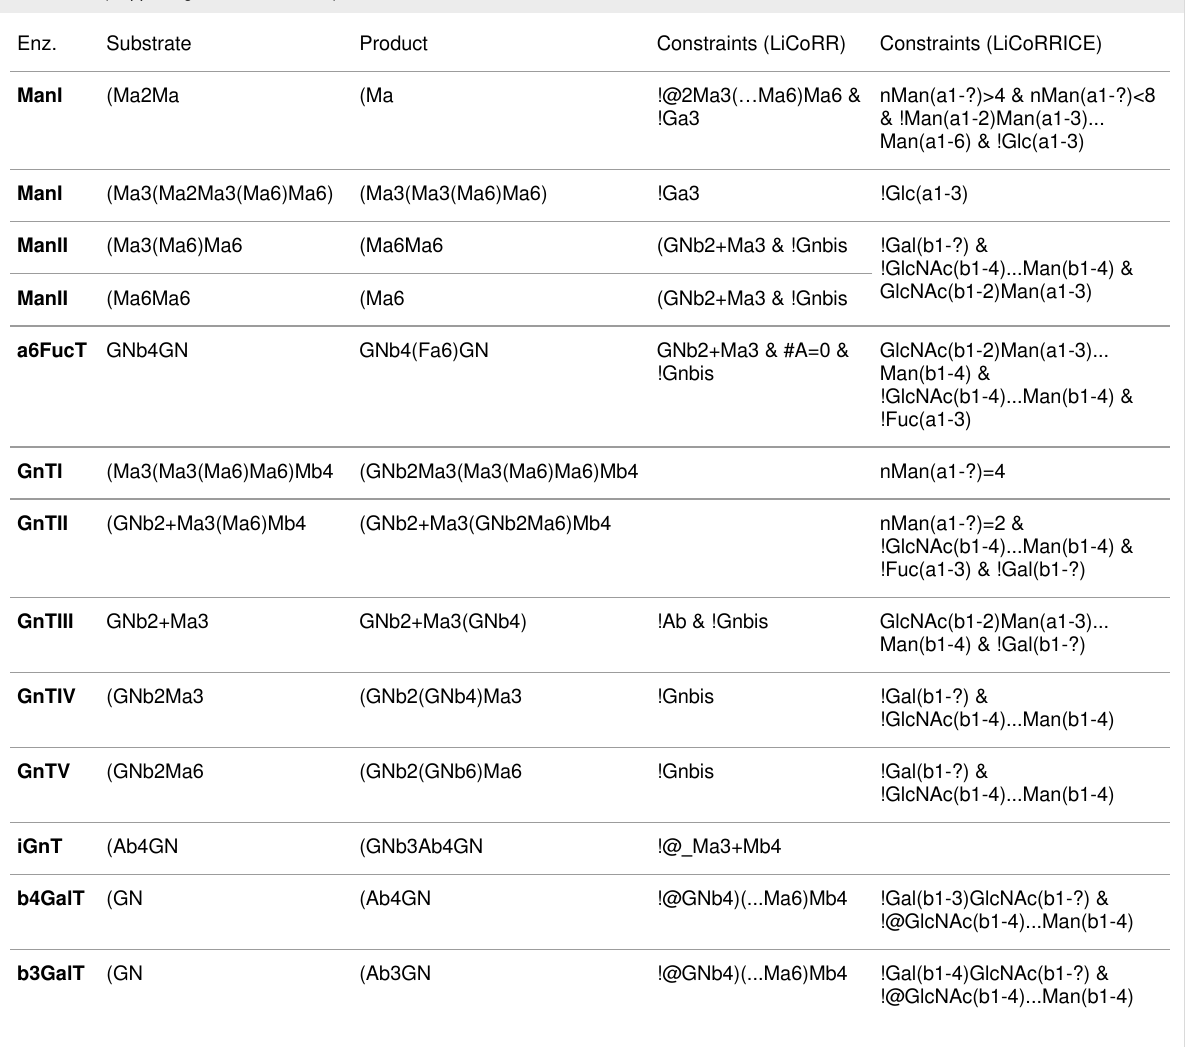
Table 9: Reaction rules from multiple N-glycan biosynthesis models in LiCoRR representation. This table describes select rules from Krambeck et al. [10] in LiCoRR and LiCoRRICE representation. Representations across multiple manuscripts can be found in Linear Code, LiCoRR and LiCoRRICE in Table S5 (Supporting Information File